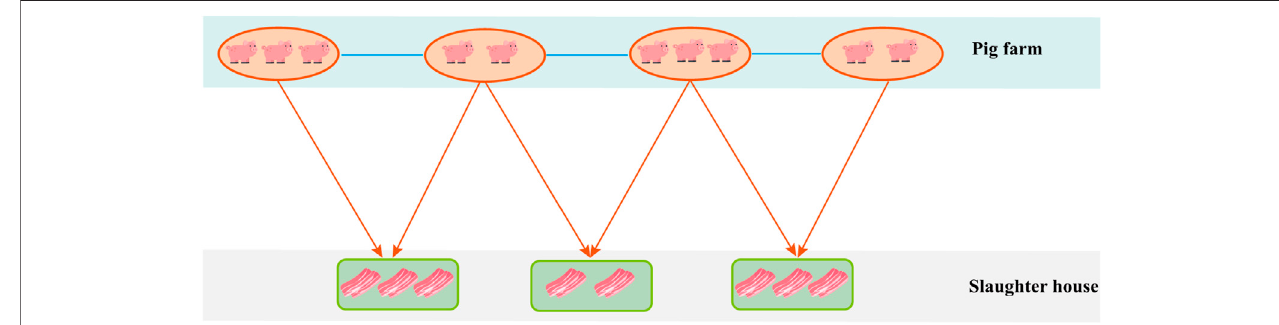
FIGURE 2 | Transmission diagram of ASFV along the live pig transport route.